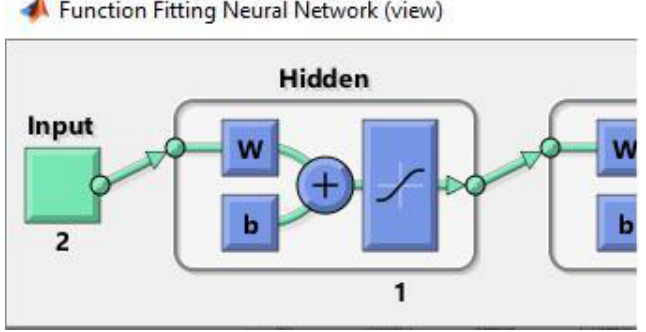
Figure 5 . Hidden layers and neurons of the projects Case 1: For epoch 12